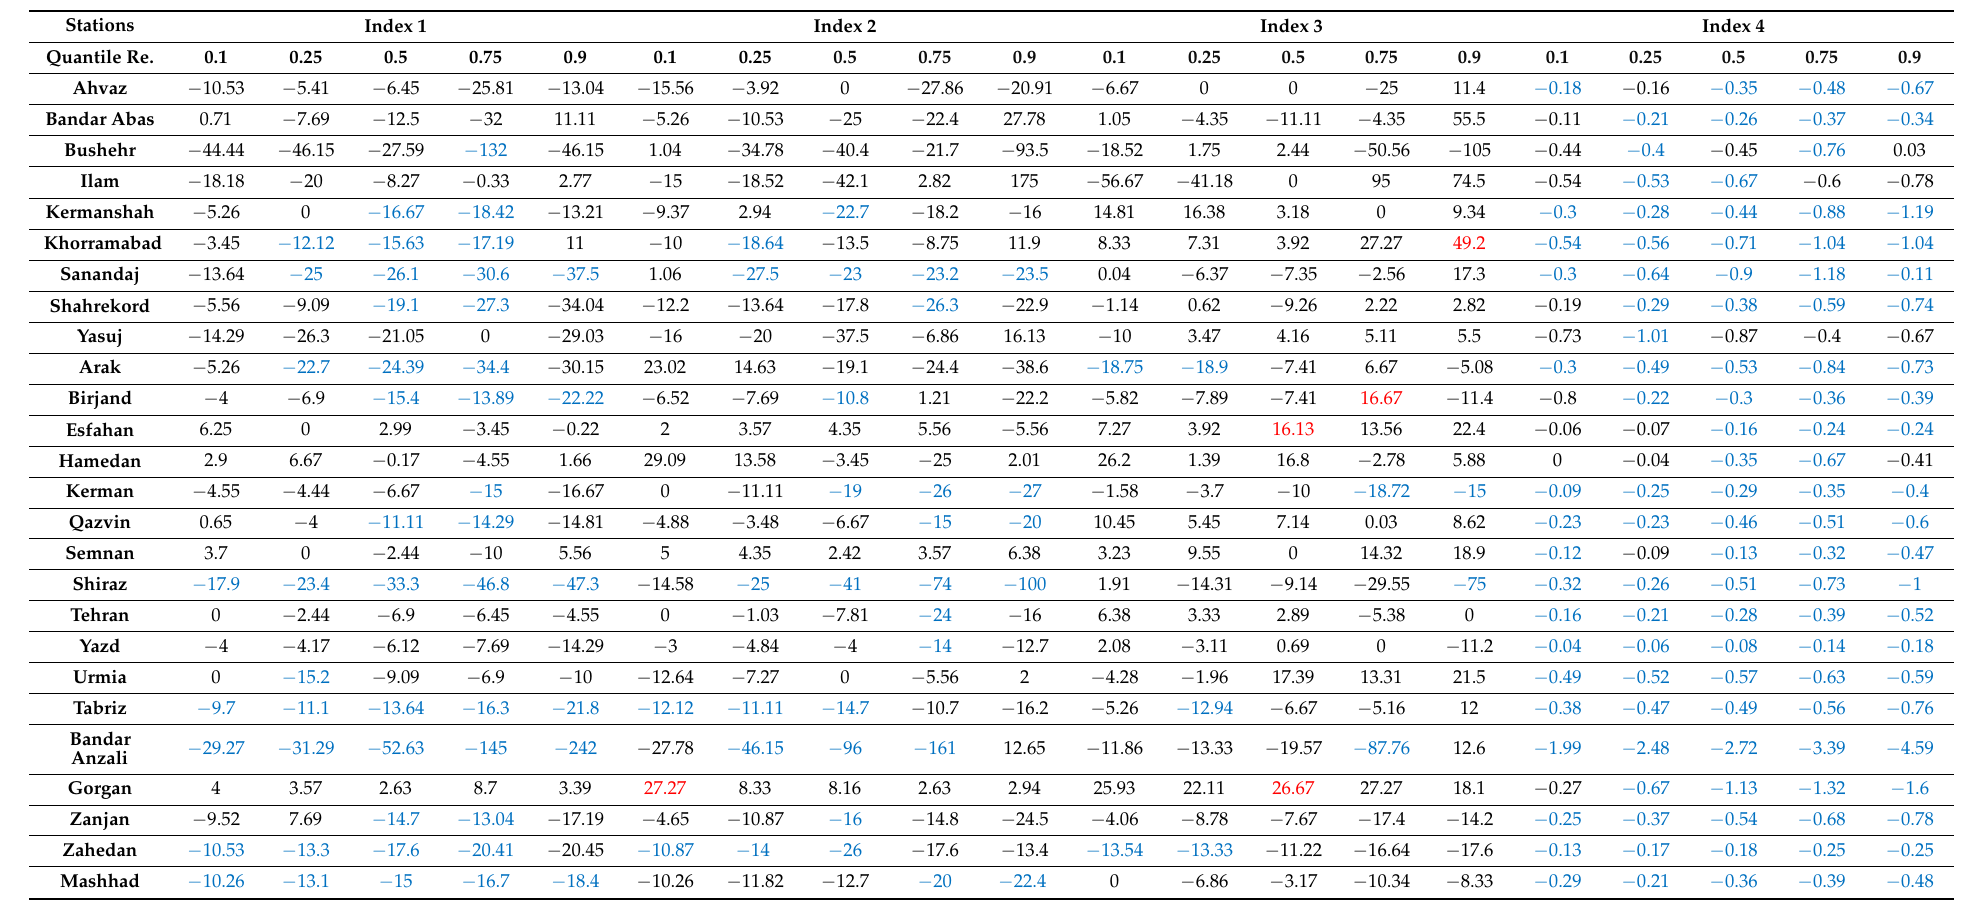
Table 4. The quantile regression coefficients for selected percentiles ( × 10 − 2 ). Blue and red numbers denote statistical significance at the 0.05 critical level downward and upwards